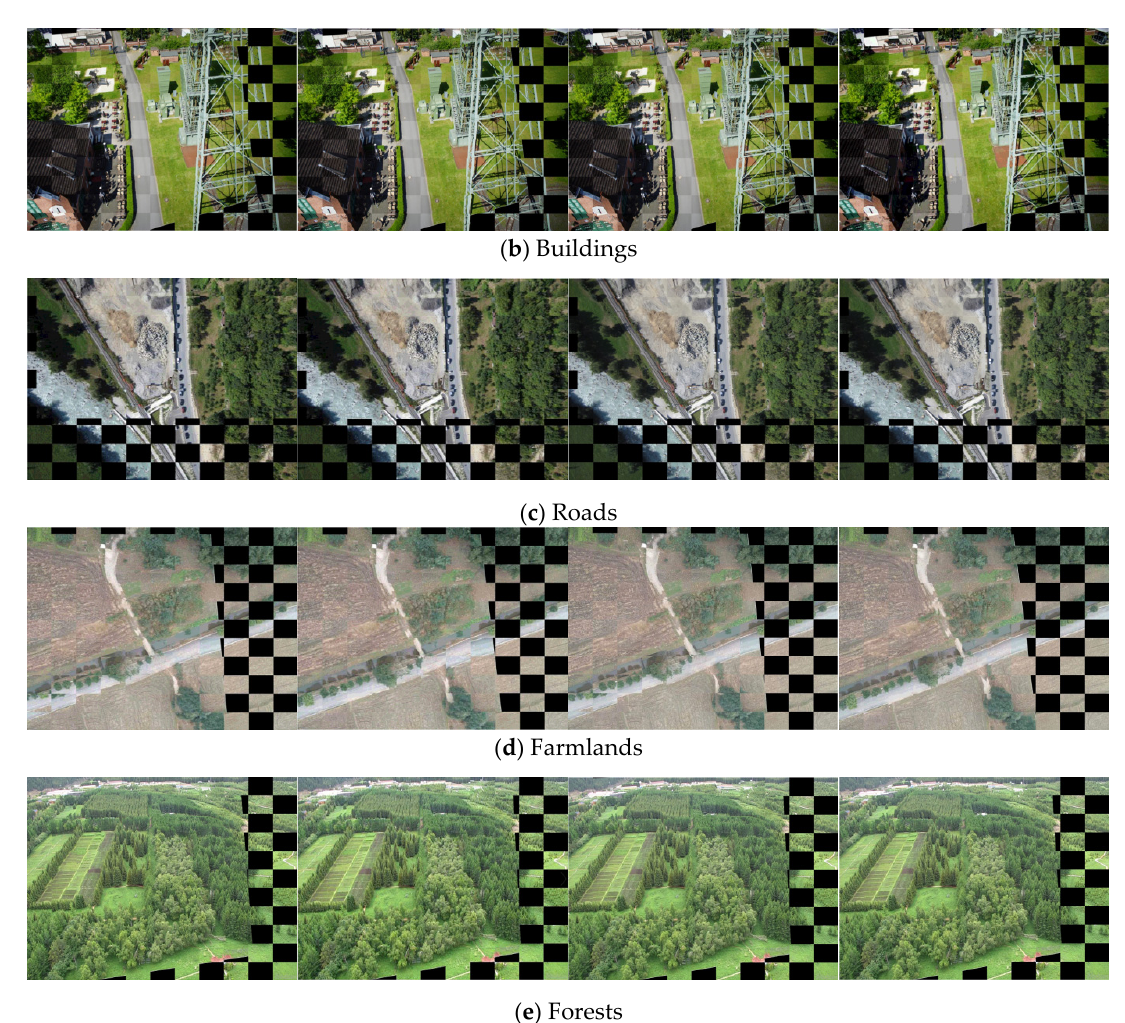
Figure 6. Checkerboard mosaicked images of five scenes obtained by four registration methods, and from left to right, they are VGG-16, DResNet-50, BResNet-50 and KResNet-50: ( a ) Urban, ( b ) Buildings, ( c ) Roads, ( d ) Farmlands and ( e ) Forests.